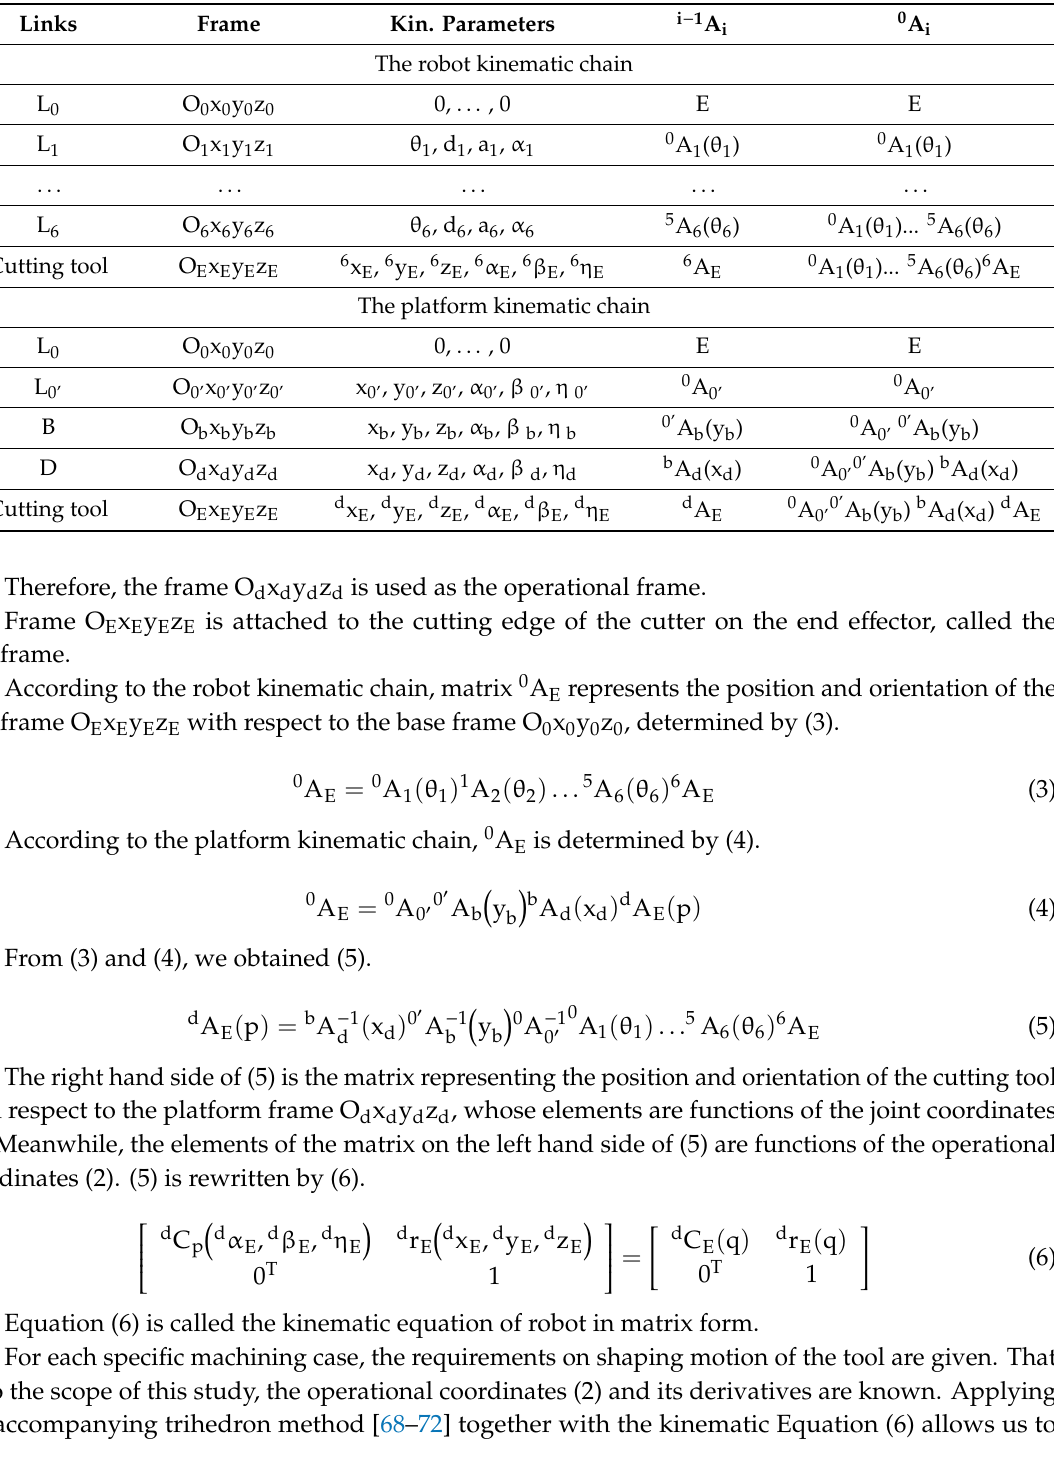
Table 1. The frames and homogeneous coordinate transformation